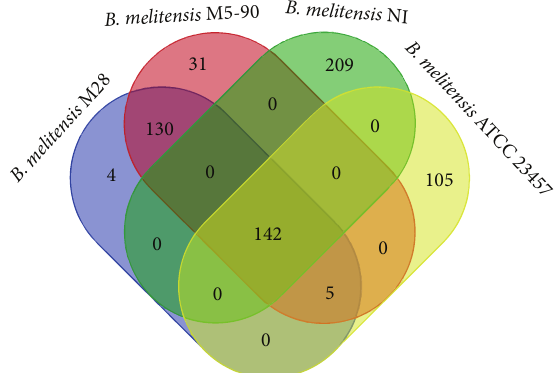
Figure 7: The Venn diagram of SNPs detected in different Asian strains against B . melitensis